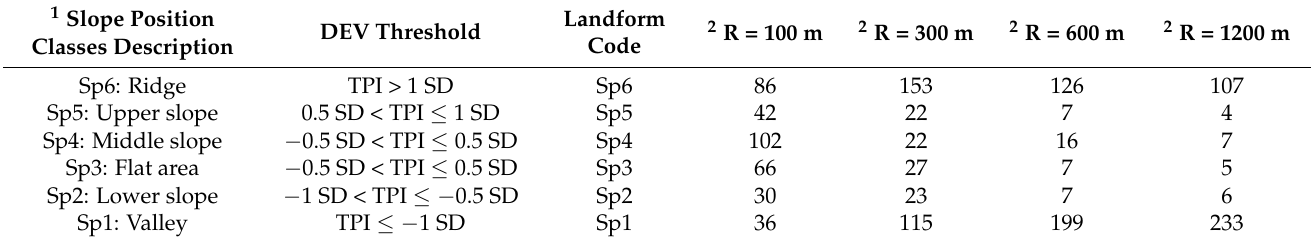
Table 3. Number of LBA archaeological sites occurring over six slope position classes in the Jijia catchment (see Figure 5).